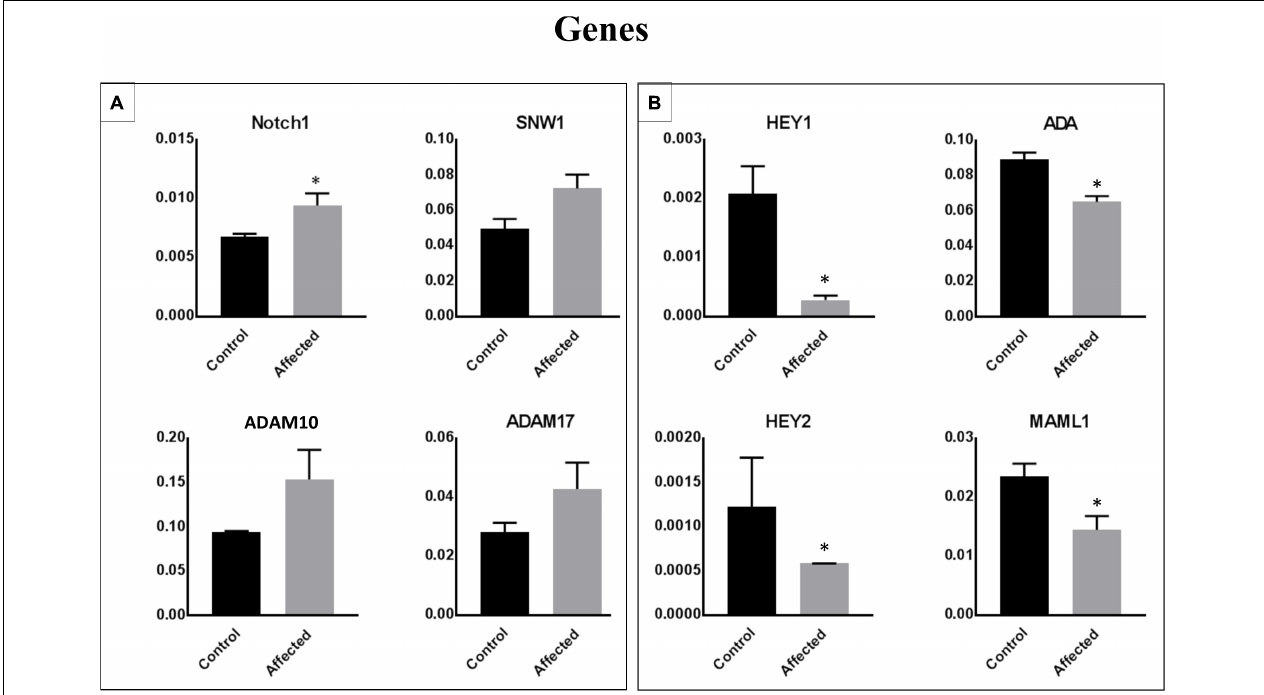
FIGURE 4 | Identification of differentially expressed genes in PBMCs obtained from patients with the DLL1 defect or controls. Cell pellets harvested from PBMCs of patients or controls were used for RNA extraction and the subsequent qRT-PCR analysis. Upregulated (A) and downregulated (B) genes in patients versus controls. The (cid:49)(cid:49) Ct analysis was performed using the SDS 5.4 (Applied Biosystems). GAPDH was used as a reference control for all analyses. Data are presented as means ± SEM. Data were analyzed using the paired t -test. ∗ P < 0.05 vs. control.